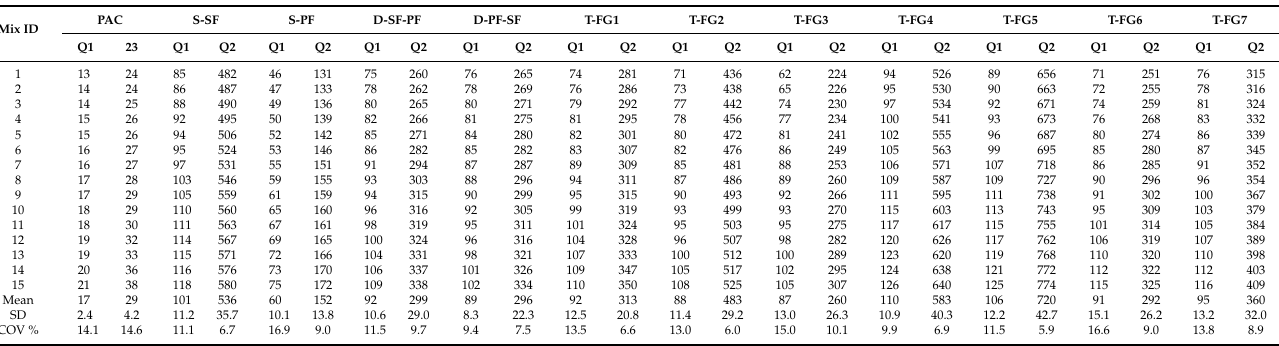
Table 3. Results from the experimental impact